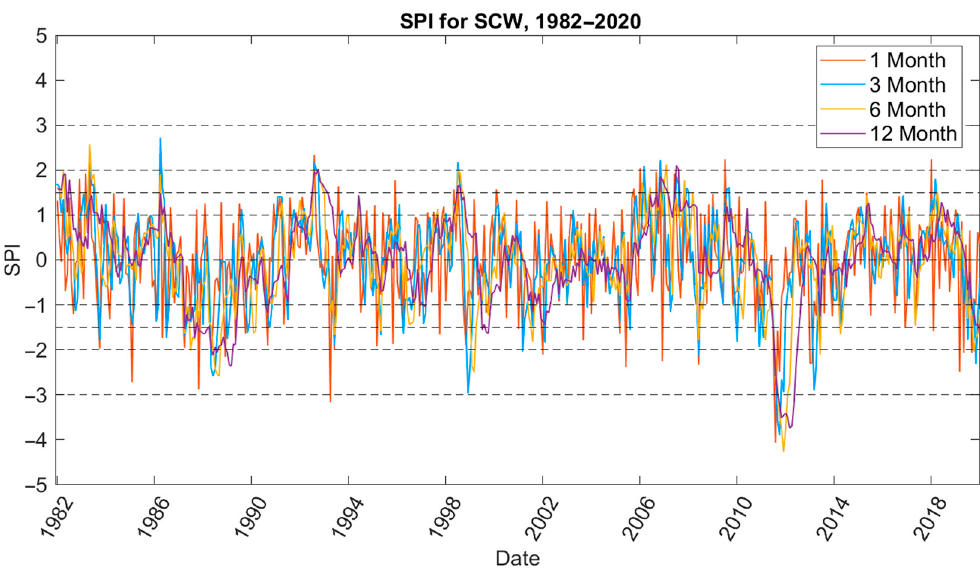
Figure A9. 1 ‐ , 3 ‐ , 6 ‐ , and 12 ‐ Month SPI from 1982 to 2020 plotted on the same axes. Figure A9. 1-, 3-, 6-, and 12-Month SPI from 1982 to 2020 plotted on the same